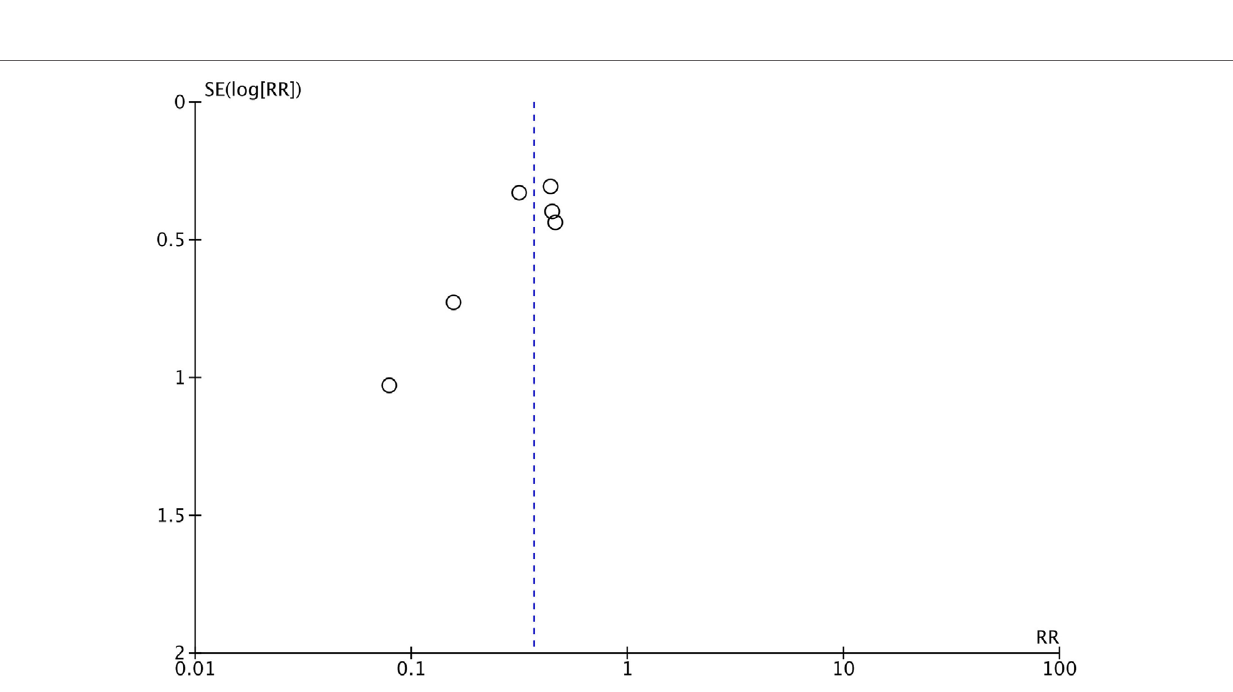
FigURe 4 | Inverted funnel plot for trials addressing the incidence of brain metastases. Abbreviation: RR, relative risk.